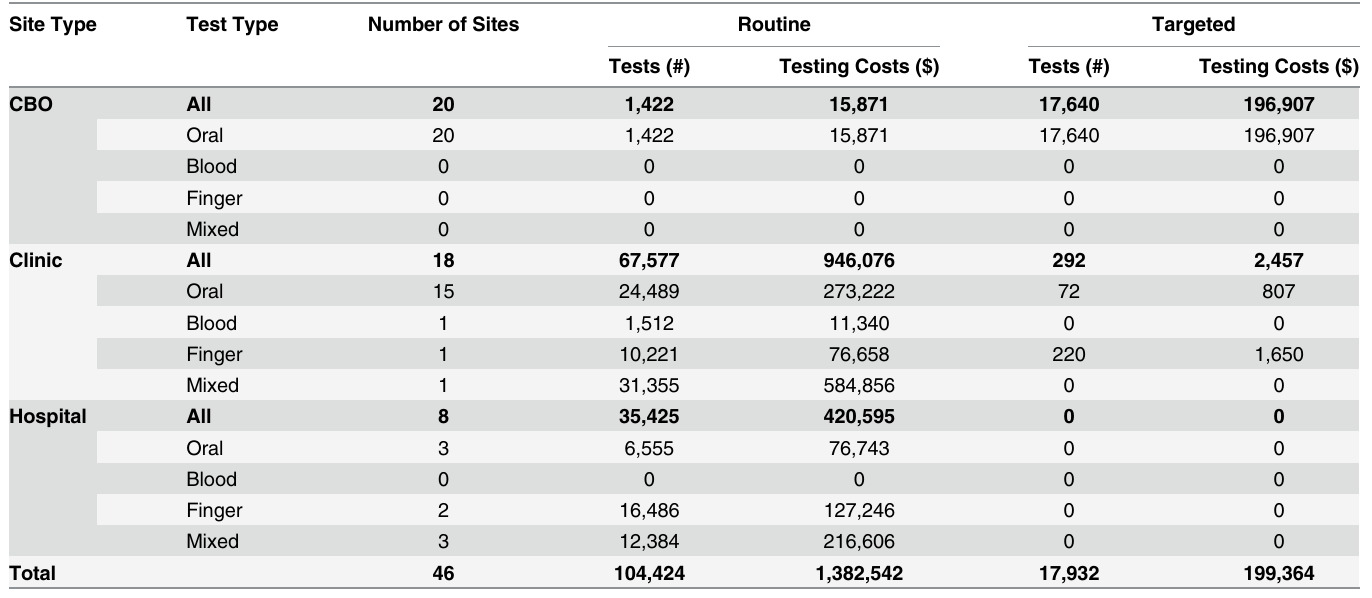
Table 1. Routine and Targeted Testing Costs by Site and Test